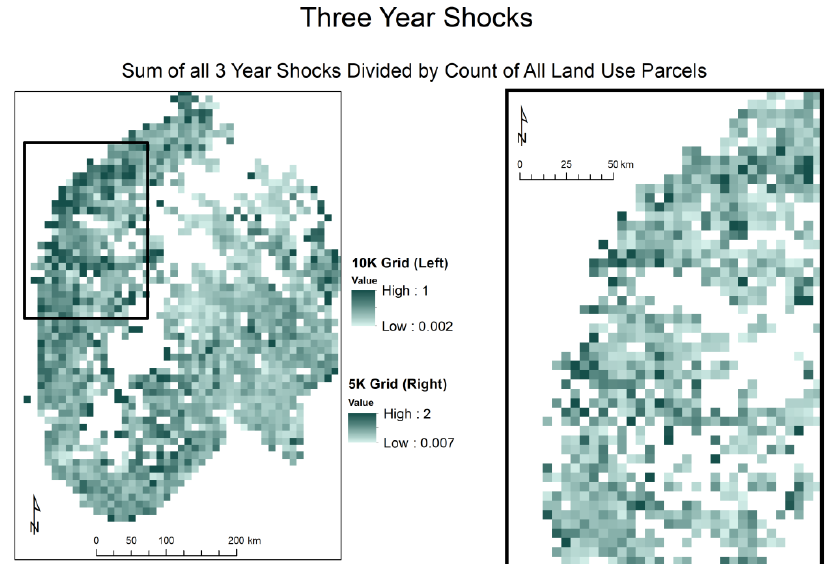
Figure 5. The map illustrates the occurrence of parcels of agricultural land not being used for any three-year period by the average number of shocks (excluding all parcels with zero shocks). The map on the left shows southern parts of Norway, while the figure on the right shows the map in the frame with higher resolution.